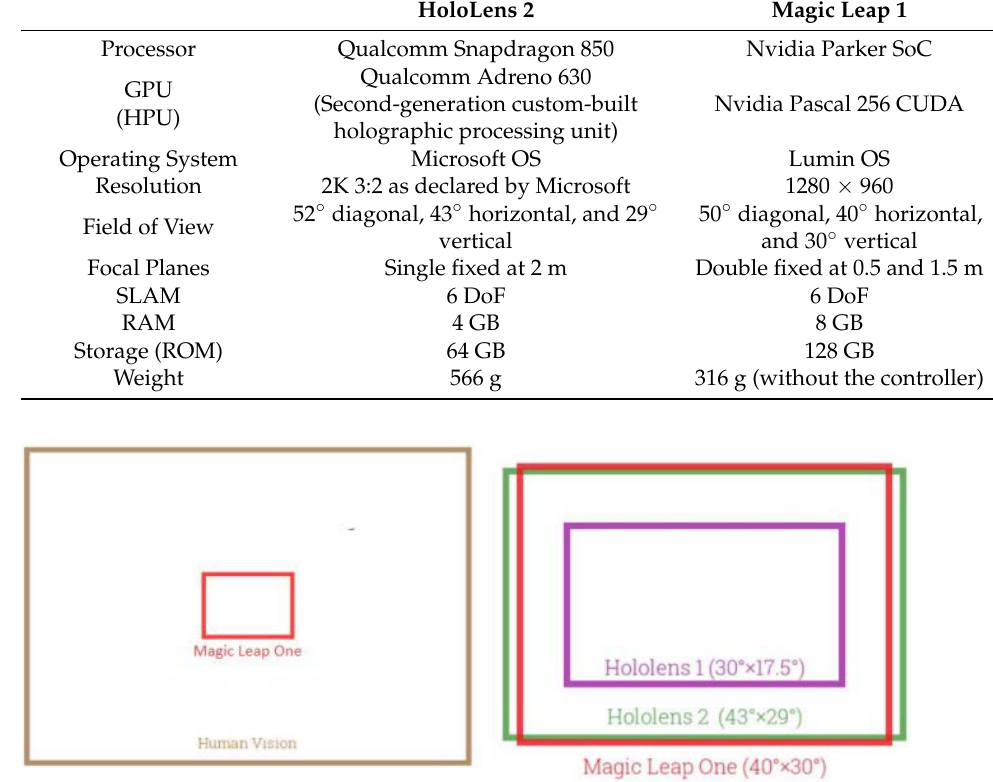
Figure 6. Field of view comparison.